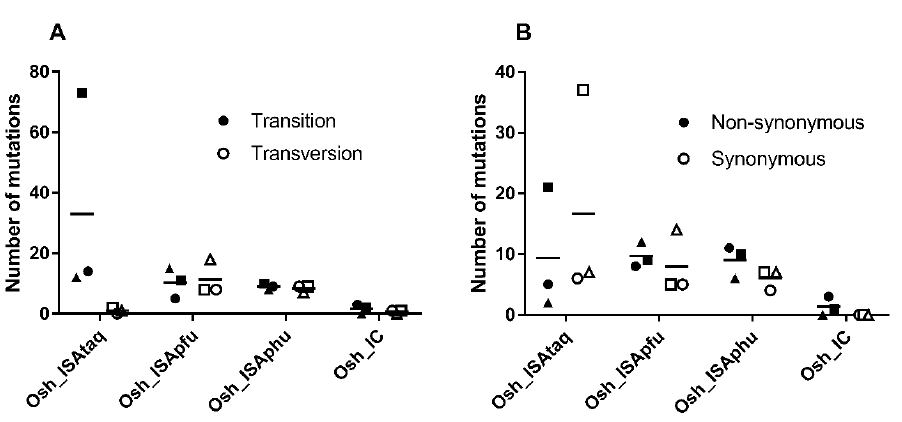
Figure 2. Mutation characteristics. The complete genome sequence of each virus was determined in triplicate. This figure represents the number of transition / transversion ( A ) and non-synonymous / synonymous ( B ) mutations. Circles, squares, or triangles correspond to the first, second, and third replicates, respectively, and dashes represent mean values.